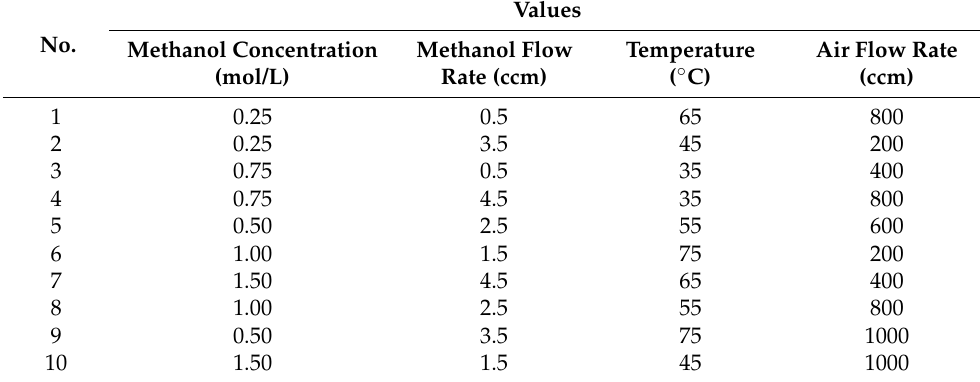
Table 2. Operating parameters.